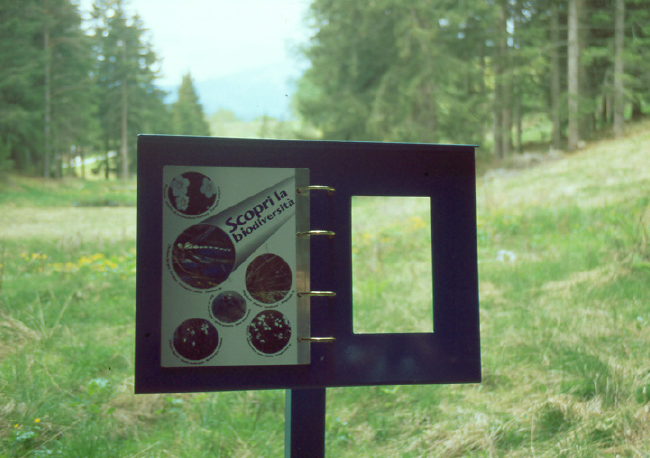
Figure 1. Panel allowing a view of the marsh behind it (South Tyrol, Italy) (Megerle 2002).